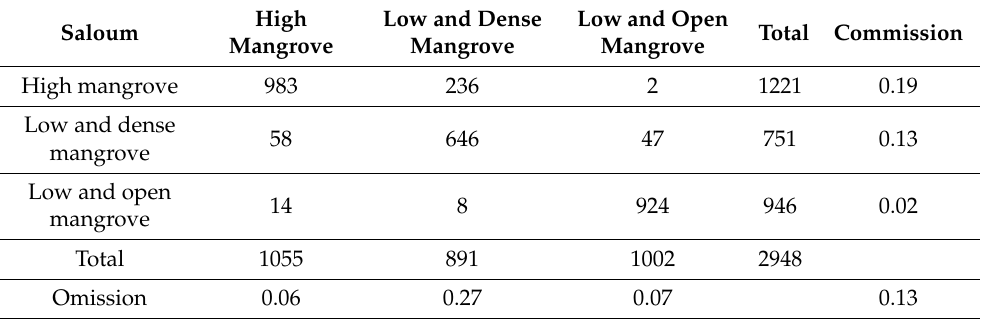
Table 3. Confusion matrix for the mangrove zonation classification in Saloum (ground truth in the rows, and categorical images in the columns).